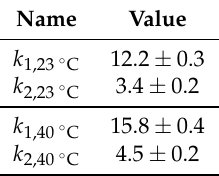
Table 1. Coefficients for Equation (15) with 95% conf.